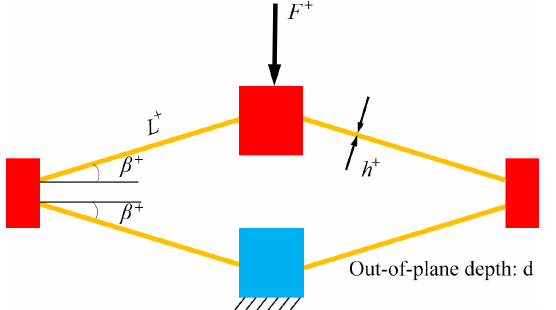
Figure 10. The structure of the V-shaped positive-stiffness mech- anism. The red, yellow and blue parts represent the moving plat- forms, the tilted flexure beams and the fixed base, respectively.